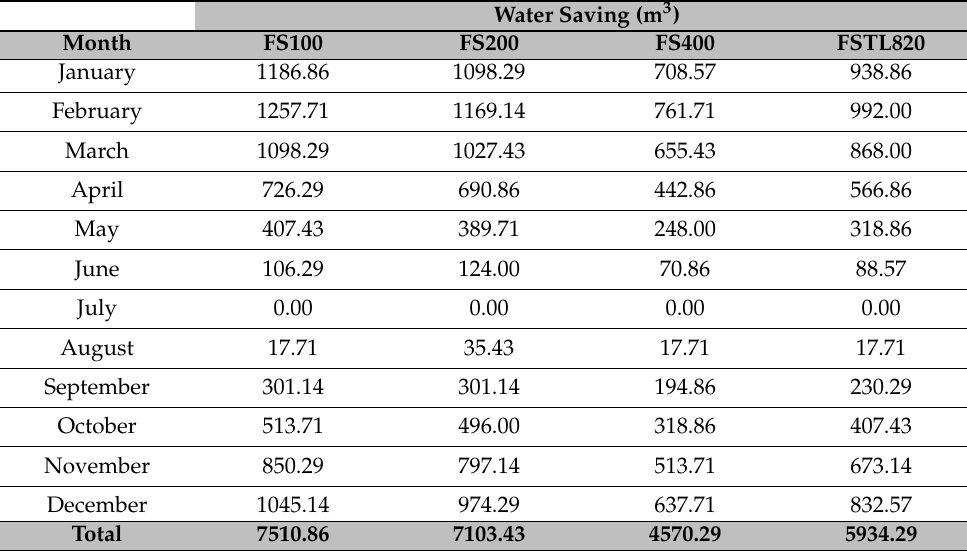
Table 10. Backwash water savings of 8 GAC filters with monthly adjustment of backwash intensity versus backwash at constant intensity throughout the year in cubic meters.